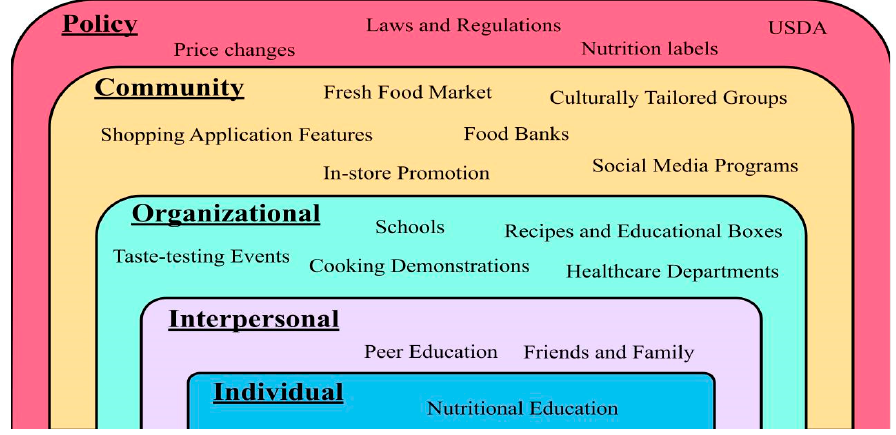
Figure 1. Multilevel approaches to increase healthy food consumption in low-income populations, based on the SEM [36].